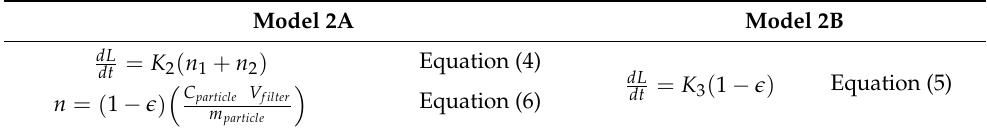
Table 7. Equation model for the change of packed bed thickness (Models 2A and